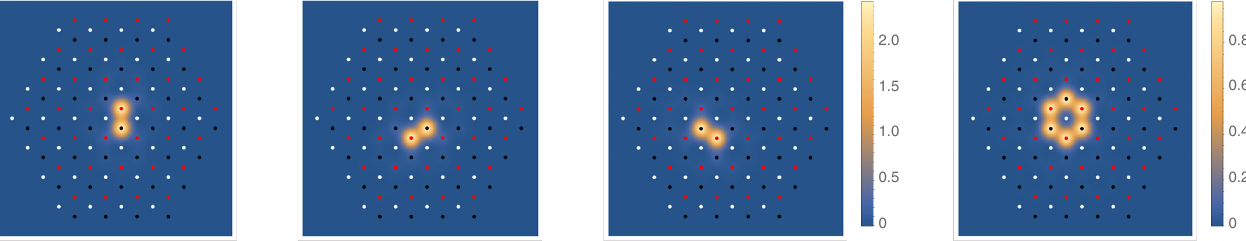
r Þj 2 for the shift insulator model with λ > 0 after the addition of two atomic orbitals at the A and FIG. 14. The Wannier functions j W n; 0 ð B sublattices ( b position). As in Fig. 13, the white, red, and black dots denote the center of the unit cell and A and B sublattices, respectively, and we use a Gaussian function centered around the corresponding position for clarity. Here, we have three rotation-related states centered at the hexagon edges ( c position) and one rotationally symmetric state centered at the hexagon center ( a